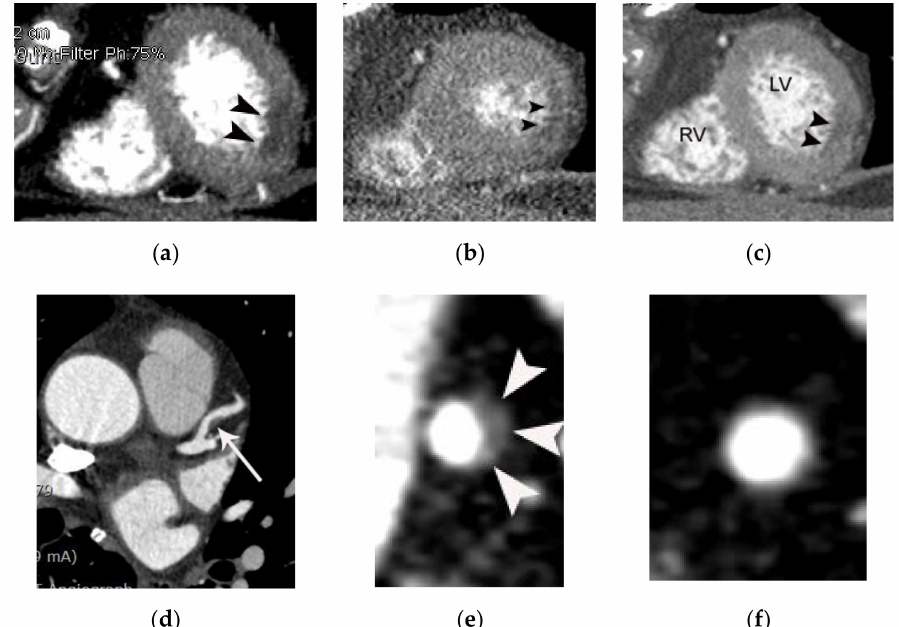
Figure 4. A case of myocardial infarction with nonobstructive coronary arteries (MINOCA) in a 66-year-old female patient. The patient presented to the emergency department (ED) with acute chest pain. Focal hypoattenuation (arrowheads in ( a )) in the lateral wall of the apex of the left ventricle is noted on a CT short-axis view. There is akinesia in the same location on a short-axis systolic image ( b ). Note the absence of wall thickening in this area on the systolic image compared to the diastolic image ( b , c ). However, the coronary arteries were normal other than nonobstructive coronary stenosis (arrow in ( d )) with noncalcified plaque and positive remodeling in the proximal left anterior descending coronary artery on an axial coronary CT image ( d ). Note the noncalcified plaque with positive remodeling on an en face view (arrowheads in ( e )) compared to the normal reference level ( f ). Subsequent coronary angiography confirms the CT findings (not shown). RV and LV indicate right and left ventricle, respectively.